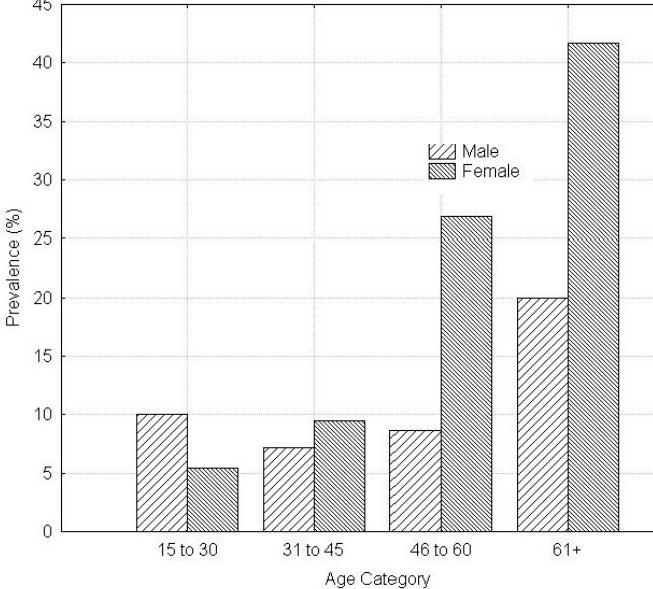
Figure 1 Age adjusted prevalence of myopia by gender